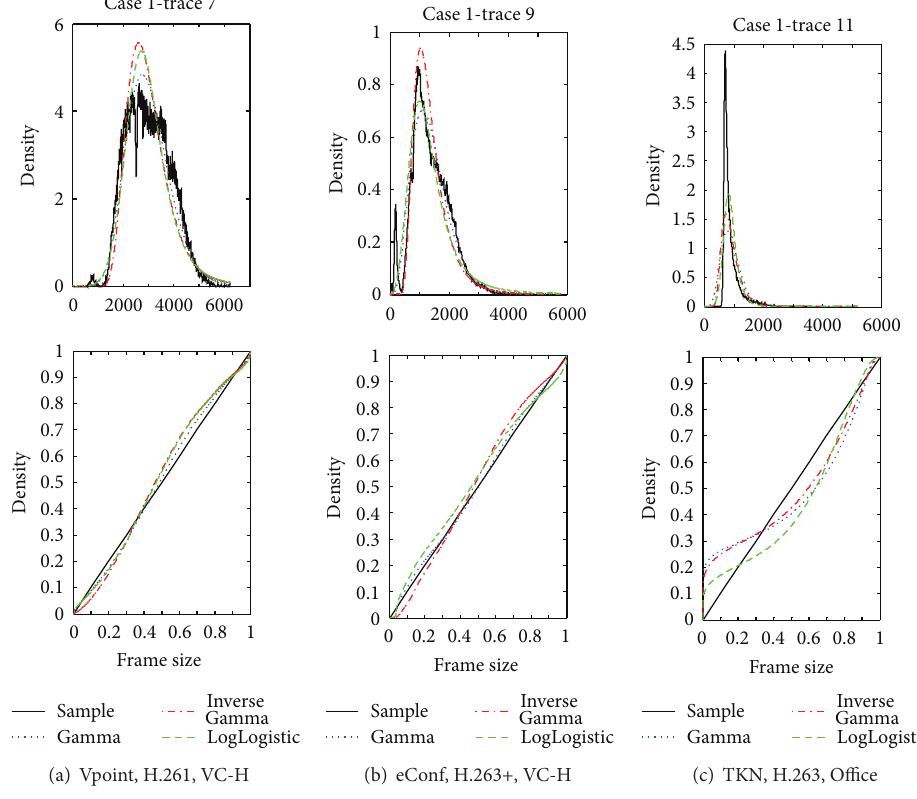
F 1: Frame-size histograms versus moment �t and the respective �-� Plots for unconstrained